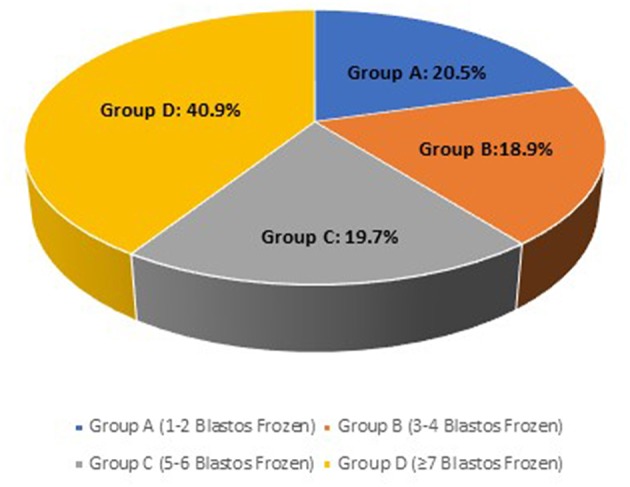
The frequency of each study group; Group A (1-2 blastocysts frozen), Group B (3-4 blastocysts frozen), Group C (5-6 blastocysts frozen) and Group D (≥7 blastocysts frozen) on the total case number.